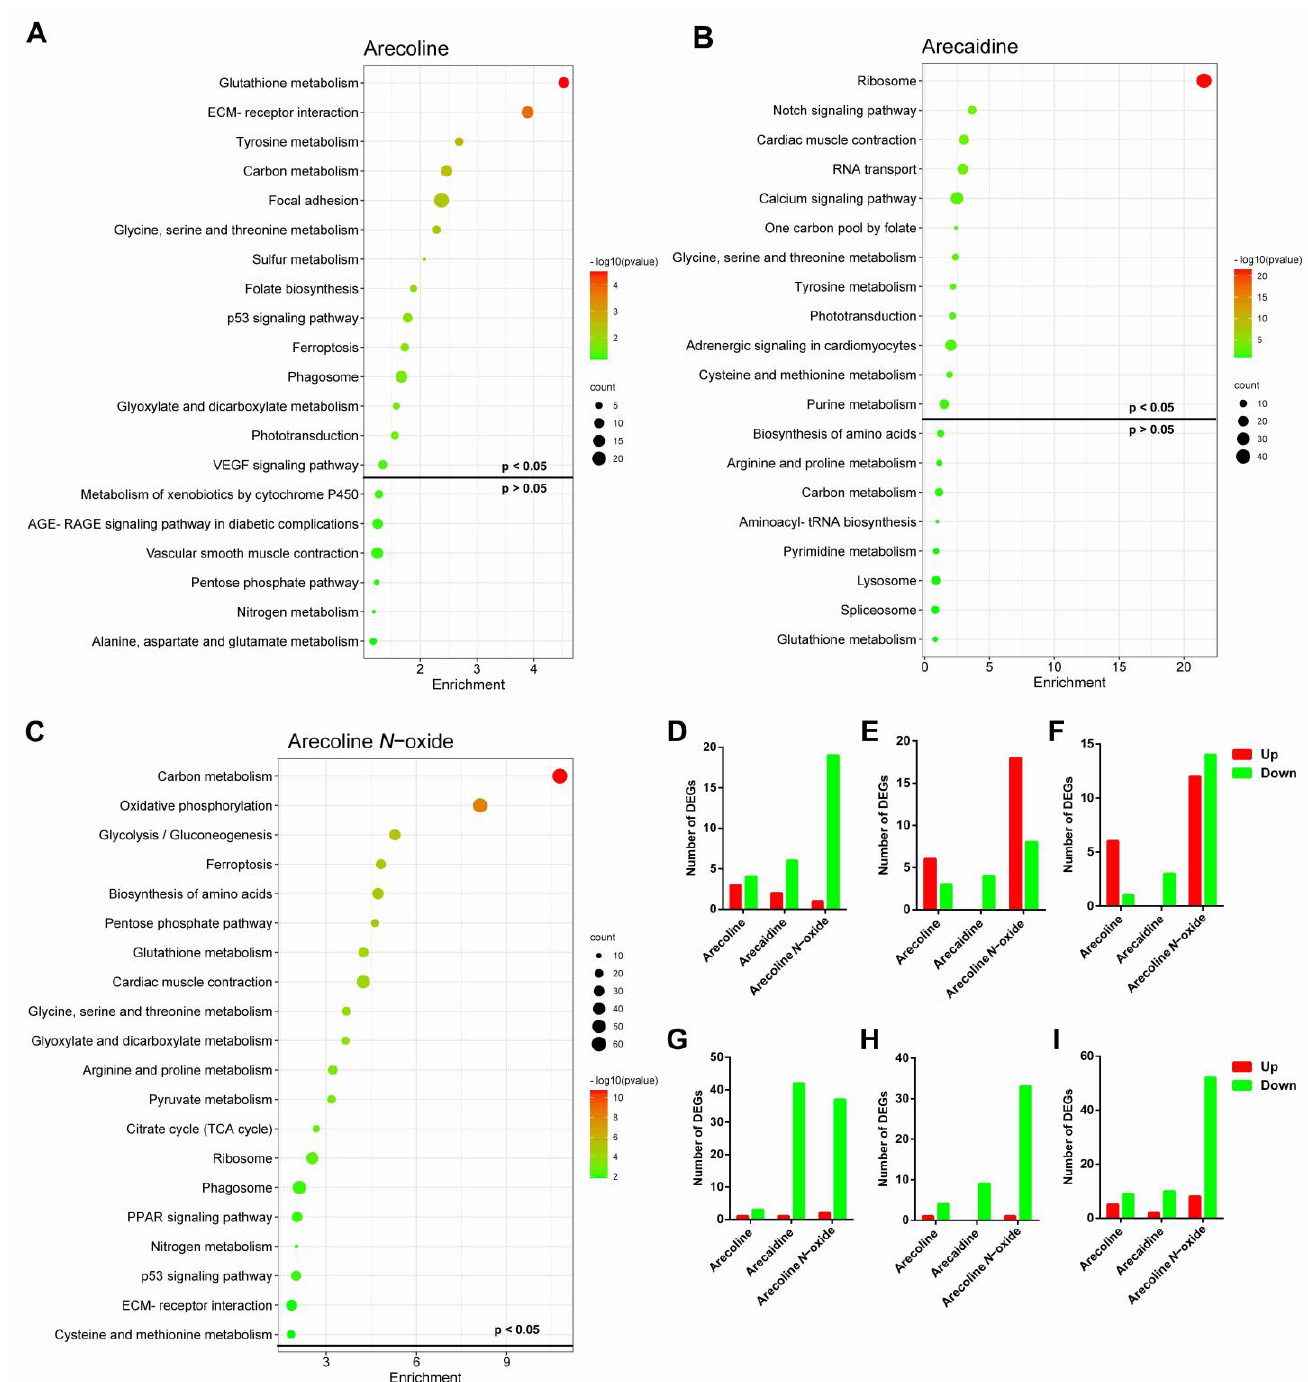
Figure 6. Enriched KEGG terms and the number of up- and downregulated DEGs in the different pathways in zebrafish embryos after exposure to areca alkaloids for 96 hpf. Enriched KEGG terms of arecoline ( A ), arecaidine ( B ) and arecaidine N-oxide ( C ). Number of DEGs in glycine, serine and threonine metabolism ( D ), p53 signaling pathway ( E ), ferroptosis ( F ), ribosome ( G ), biosynthesis of amino acids ( H ), and carbon metabolism ( I ).